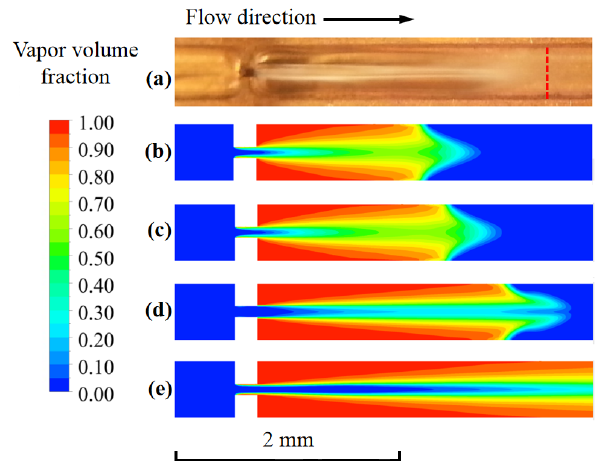
Figure 4. The comparison of vapor-liquid distribution between the experimental data [30] and simulation results, ( a ) experimental result; ( b ) standard k - ε model; ( c ) realizable k - ε model; ( d ) standard k - ω model; and ( e ) k- ω Shear-Stress Transport (SST) model.